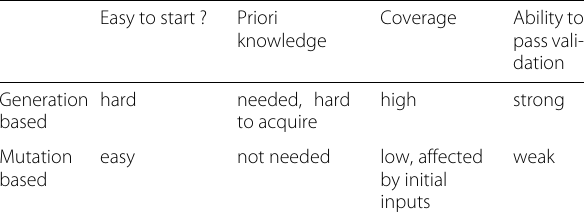
Table 2 Comparison of generation based fuzzers and mutation based fuzzers